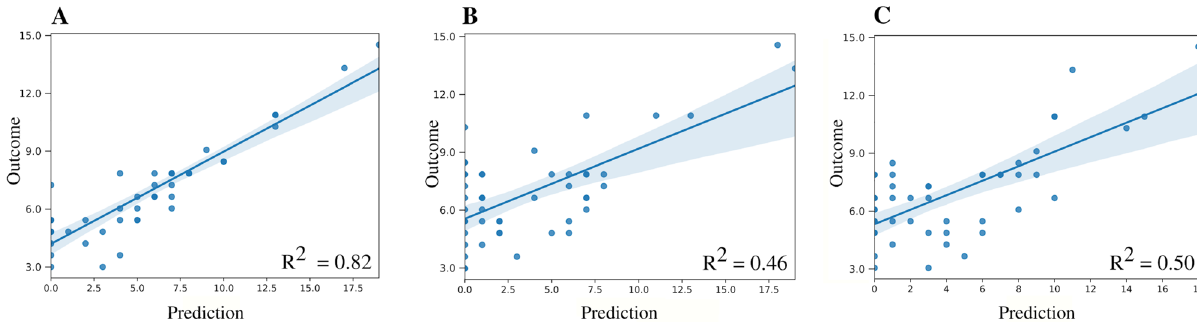
Figure 5. Multivariate prediction at the group level. The relationship between outcome and prediction of the general linear model is demonstrated using ( A ) both the structural and functional descriptors together, ( B ) the functional descriptors alone, and ( C ) the structural descriptors alone. The corresponding R 2 values are 0.82, 0.46 and 0.5,